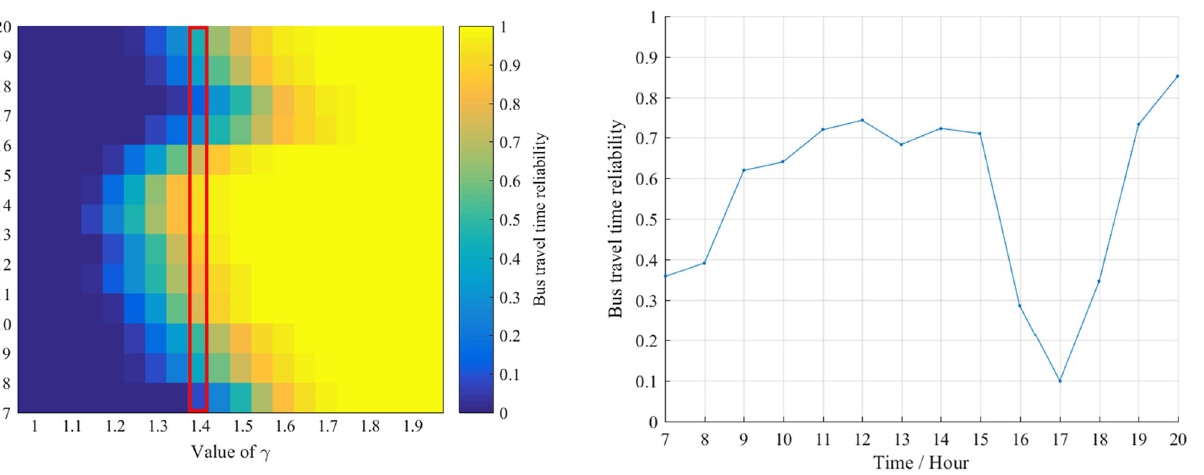
Fig. 3 Bus travel time